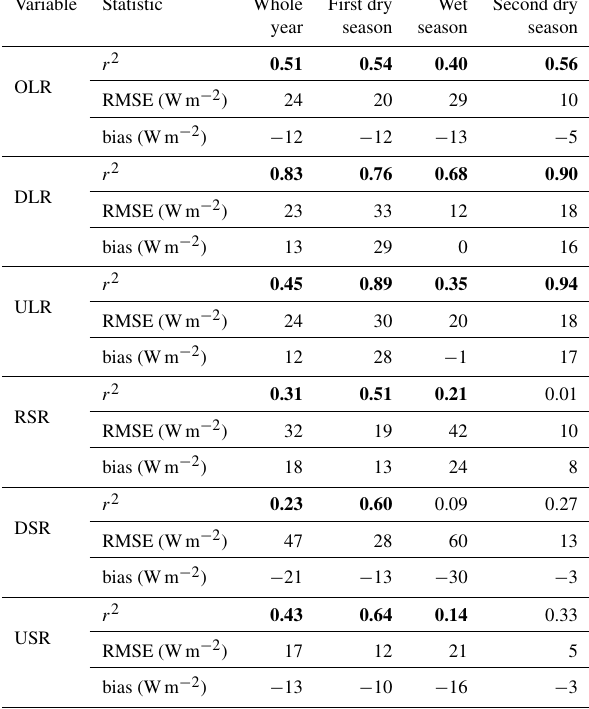
Table 2. Statistics from observation–43r1 comparison of radiative variables for the whole year (days 7–341), first dry season